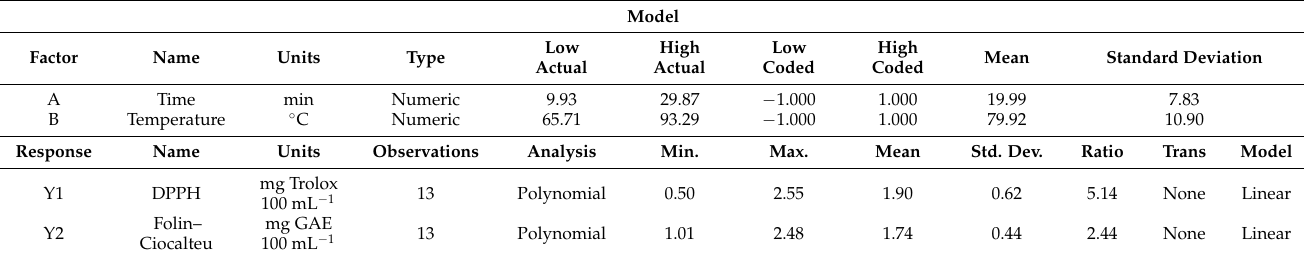
Table 1. Design summary of models obtained for extraction from